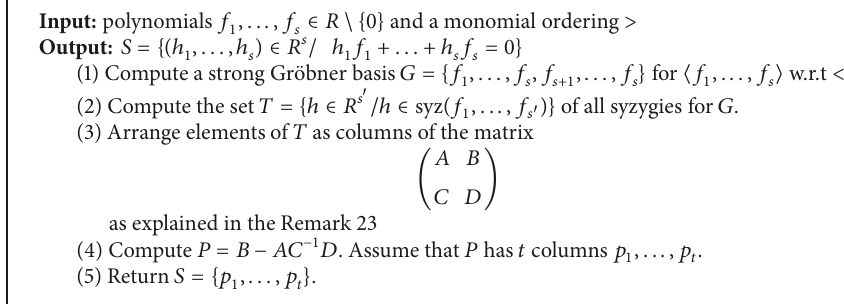
Algorithm 4: Algorithm for computing the module of